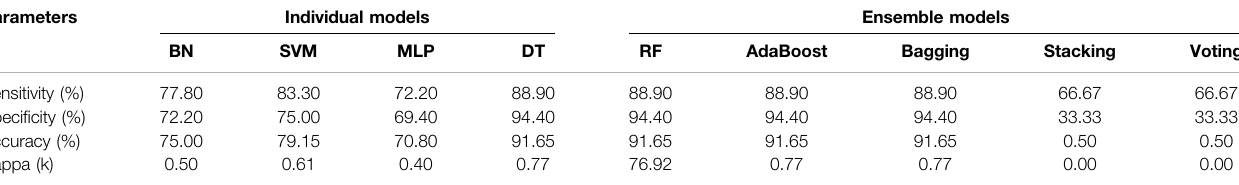
TABLE 7 | The evaluation of different ML techniques in the test dataset using different performance